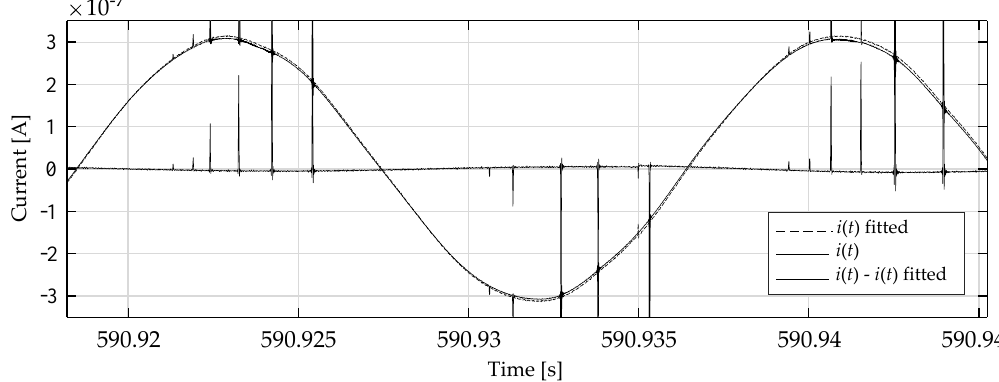
Figure 9 . The actual current as well as the discharge free current from the regression calculation current during 1.5 periods of an experiment after the inception of an electrical tree.